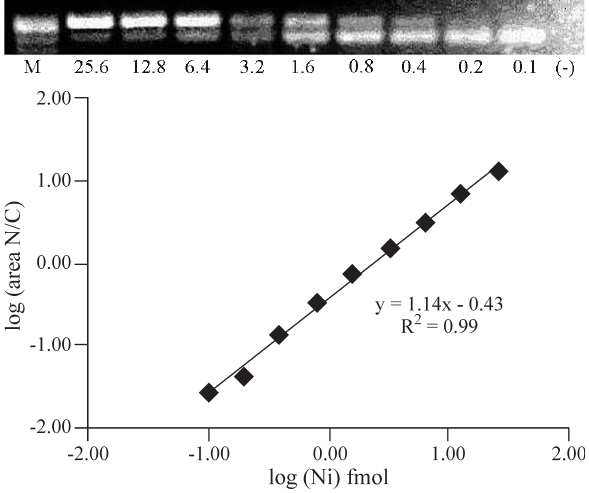
Figure 1 - Fatty acid synthase (FAS) mRNA standard curve. A = Electro- phoresis on 3% agarose gel of the FAS standard curve at 10 -3 femtomoles (fmol). B = Standard curve for FAS mRNA concentration at 10 -3 fmol. The log 10 of the ratio of native to competitor PCR product was plotted against the log 10 of the initial native fragment added to the competitive re- verse transcriptase PCR (RT-PCR). M = molecular weight